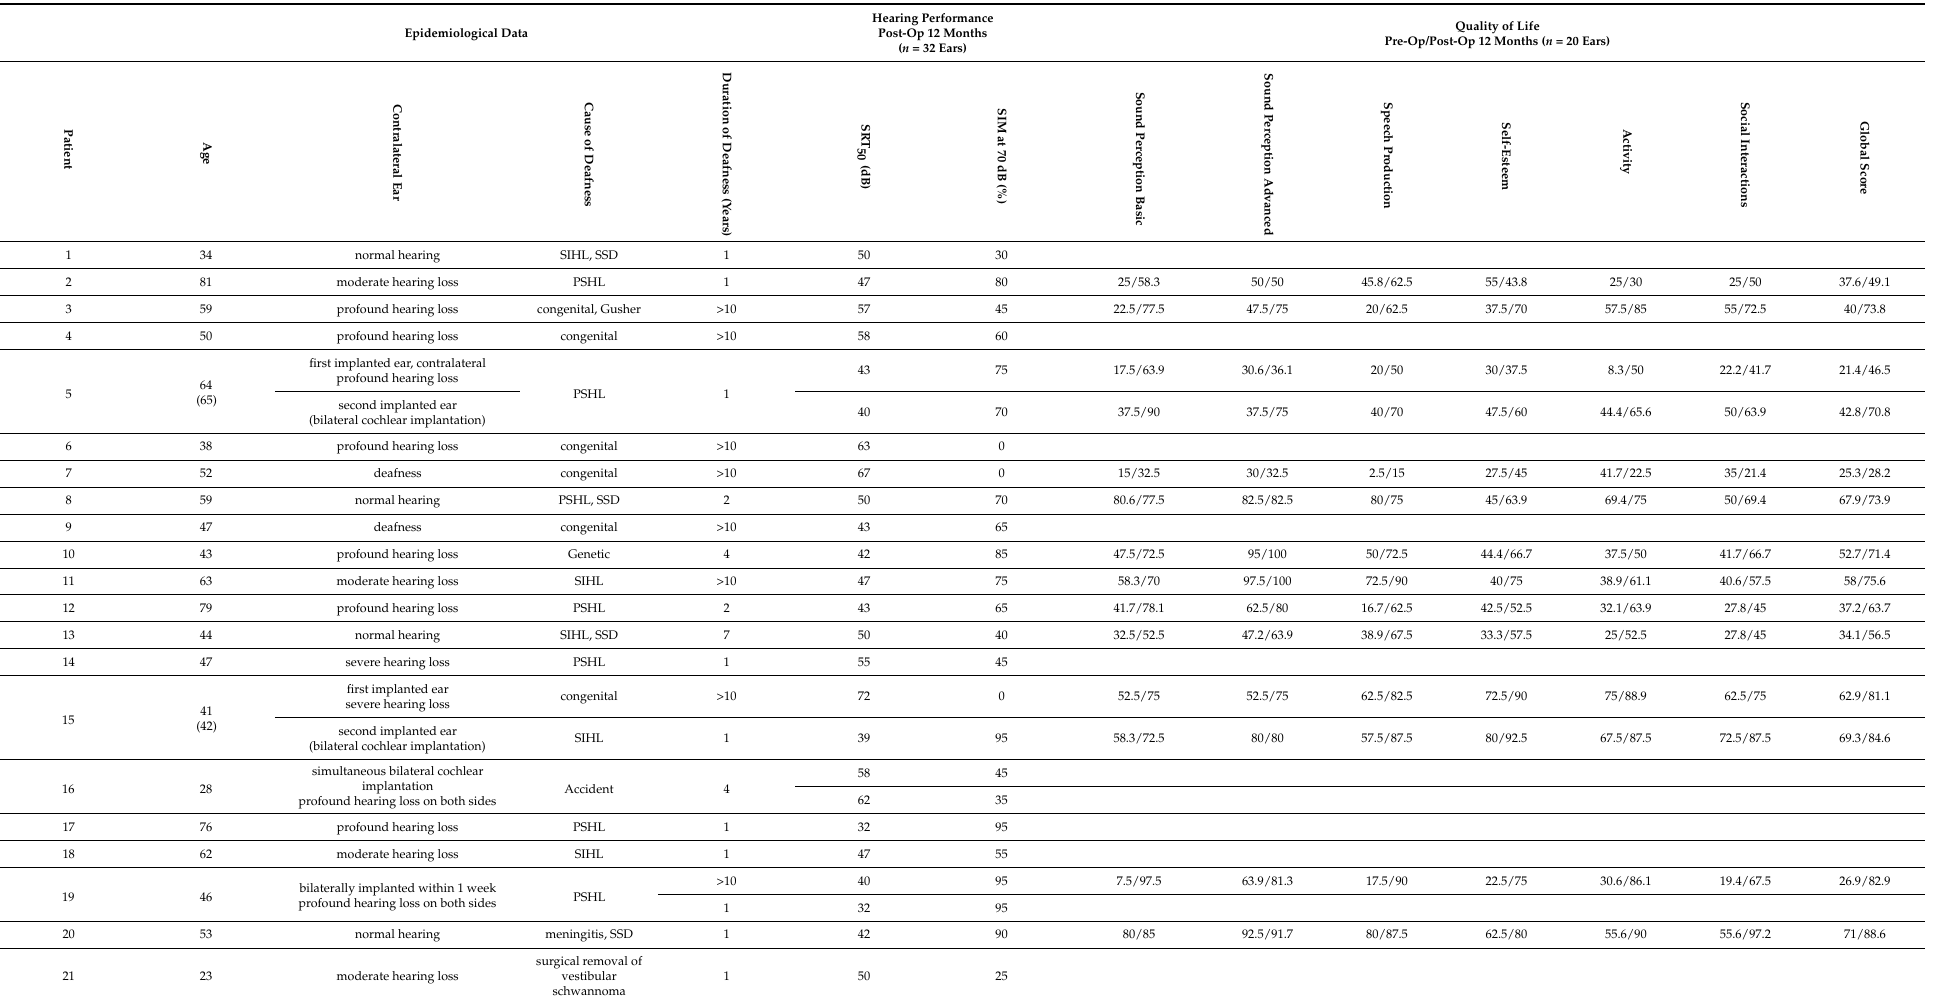
Table 2. Epidemiological data, hearing results and quality of life scores of all patients in the study. EpidemiologicalData